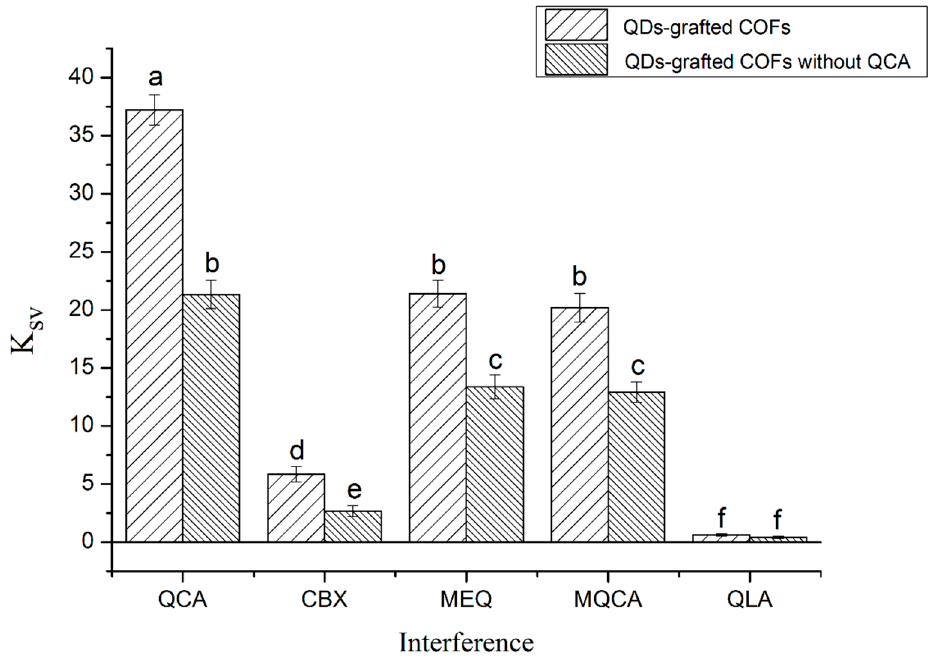
Figure 5. Results of the interferences of QCA and its structural analogs on QDs-grafted